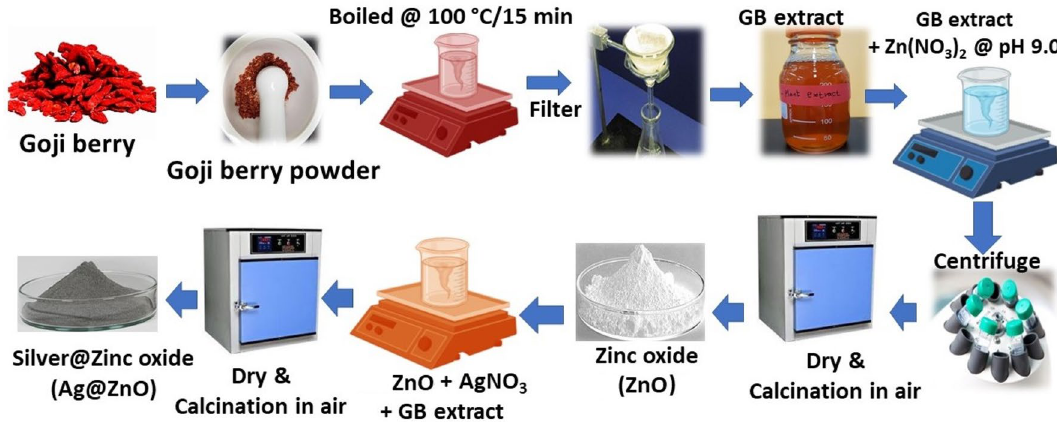
Figure 1. Schematic diagram of the synthesis of ZnO and Ag@ZnO